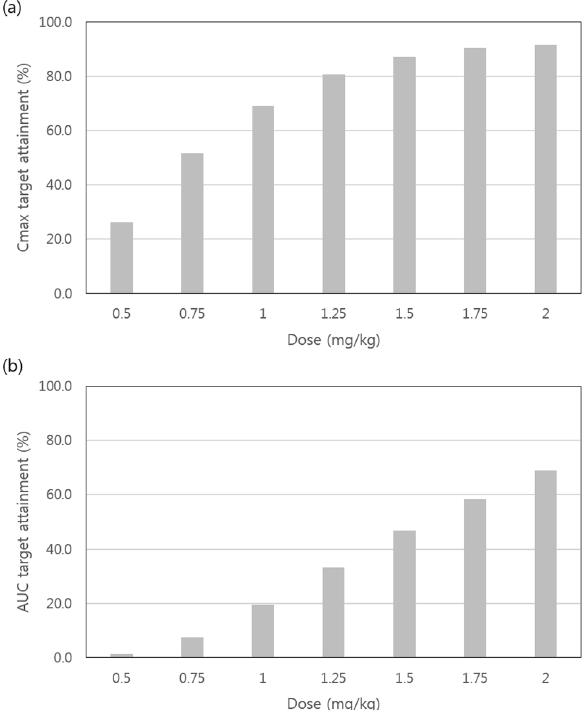
Figure 6. Percentage of reaching therapeutic exposure according to sildenafil dose. The therapeutic exposure for the ( a ) C max and ( b ) AUC were set as follows: the C max , 47, 140, and 373 ng/mL, which are expected to inhibit type 5 phosphodiesterase activity in vitro by approximately 53%, 77%, and 90%, respectively 14 ; and the AUC, sildenafil and N-desmethyl sildenafil combined with an AUC > 2650 ng∙h/mL, which previously showed clinical efficacy in infant patients 15